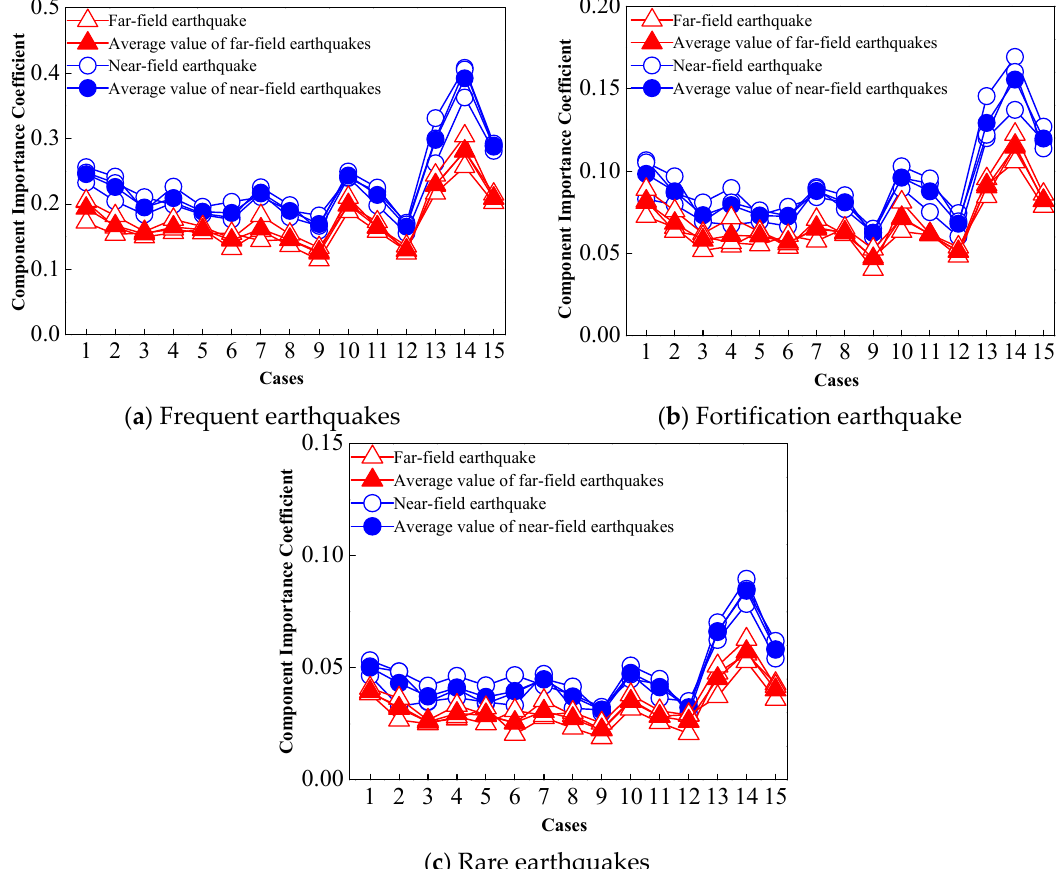
Figure 7. Component importance coefficient curves of model B.